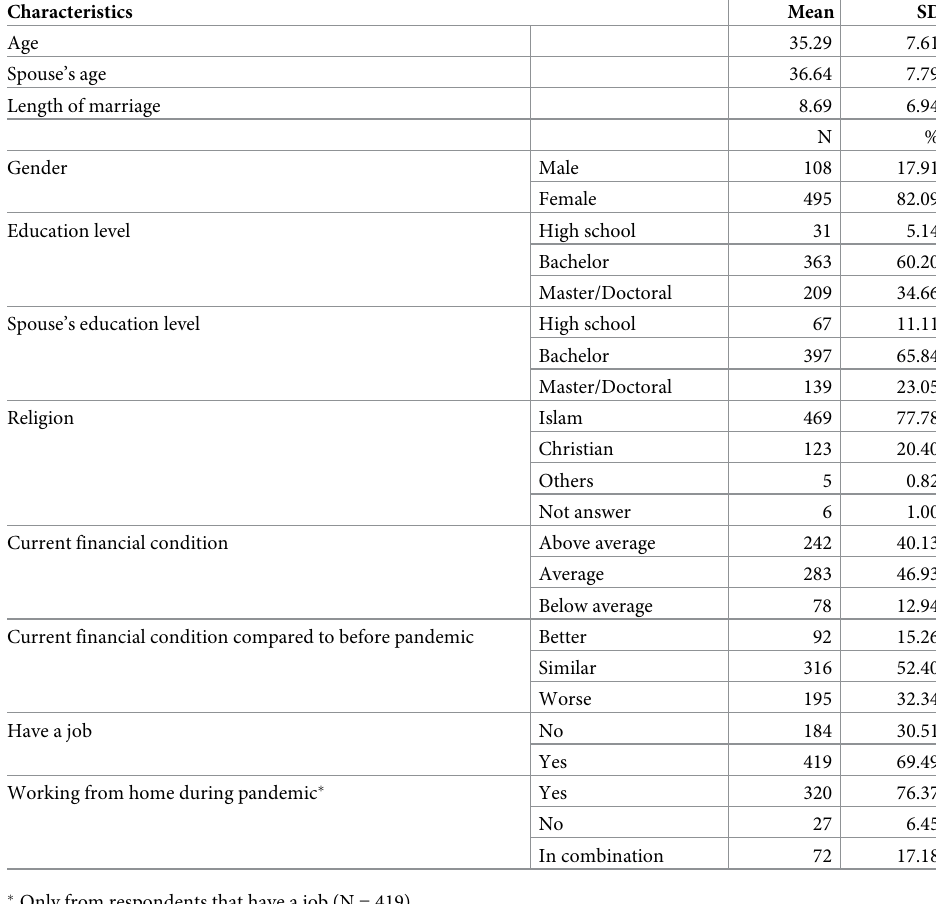
Table 1. Socio-demographic characteristics of